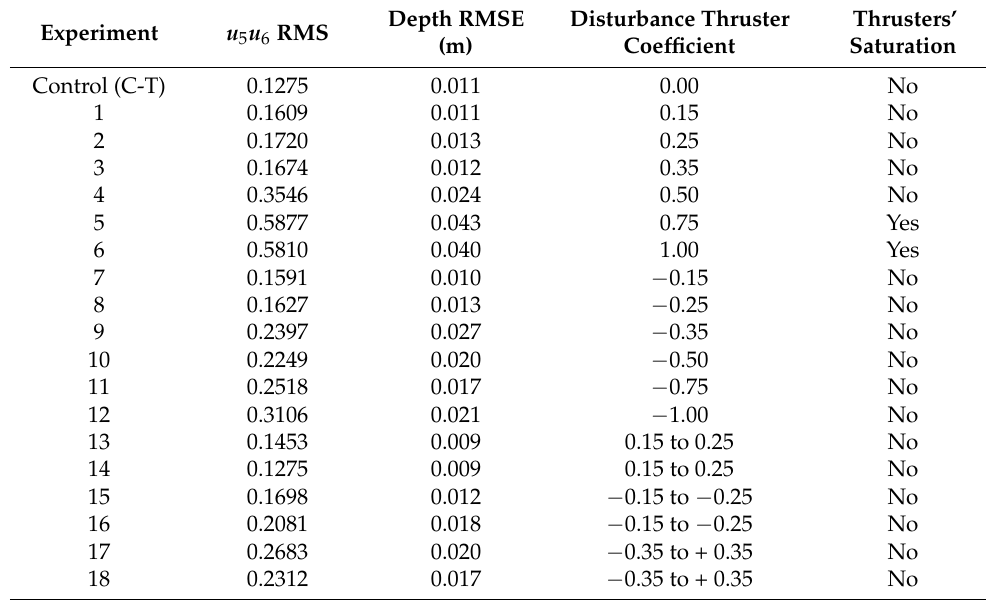
Table 4. Experimental results for the vertical thruster coefficients in the station-keeping